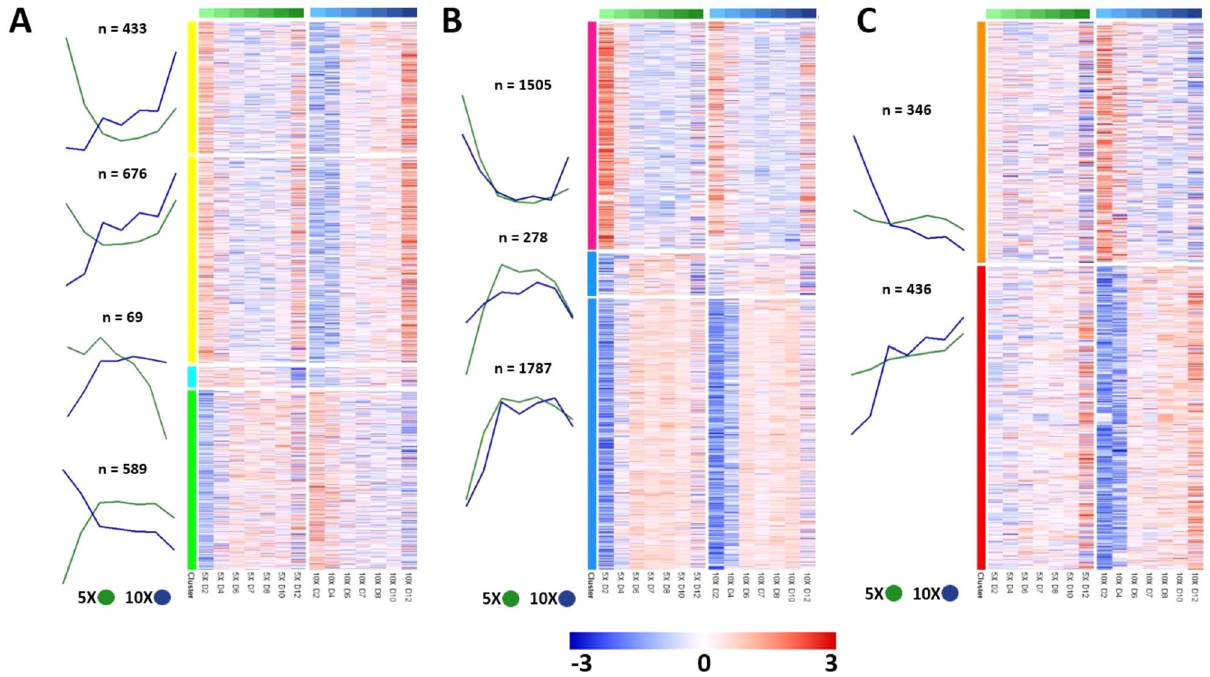
Figure 3. Somatic cells from follicles cultured in 5X versus 10X have distinct gene expression profiles in nine gene subsets. Mean expression plots with gene number and per-gene heatmaps for ( A ) gene subsets with different expression in 5X versus 10X, ( B ) gene subsets with similar expression in 5X versus 10X, and ( C ) gene subsets with more dynamic expression in 10X versus 5X. All plots were generated using pheatmap (version 1.0.12) 62 in R (version 3.6.9, https:// www.r- proje ct. org/) 55 in blue in Fig. 2B) mainly contains genes with delayed upregulation on Day 4 and a decline in regulation between Days 10 and 12. Genes of interest with high logFC in this cluster include Aurkb , Birc5 , and Mcm5 , which code for aurora kinase B, baculoviral inhibitor of apoptosis repeat-containing 5 (BIRC5), and the protein MCM5 respec- tively, all of which have known roles in the cell cycle and apoptosis, and Nlrp14 , coding for the protein NOD-like receptor family pyrin domain containing 4 (NLRP14), which has been studied in relation to primordial follicle survival and may have other roles in later stages of folliculogenesis 27,28 . All five top GO terms for this cluster were associated with cell cycle activity: “cell cycle” (GO:0007049, 267 genes), “cell cycle process” (GO:0022402, 217 genes), “mitotic cell cycle” (GO:0000278, 173 genes), “mitotic cell cycle process” (GO:1903047, 165 genes), and “nuclear division” (GO:0000280, 147 genes) (Supplemental Dataset S1). This period of upregulation from Days 4 to 10 reflects the proliferation of granulosa cells during follicular expansion, which ceases once the follicle has reached a terminal size (Fig. 2C). GOrilla analysis corroborated these findings, also reporting enrichment for terms related to DNA replication and the cell cycle (Supplemental Dataset S2). The fifth cluster (n = 1928 genes, labeled in orange), was comprised of genes with delayed activation, as they were upregulated starting on Day 6 (Fig. 2B). Genes of interest within this cluster included glycolysis-related genes like Aldoc (coding for aldolase C) and Pfkp (coding for phosphofructokinase), noteworthy because granulosa cells are known to have highly gly- colytic metabolic processes often regulated by oocyte-secreted factors 29 . The top GO terms for this cluster from LRPath were all related to metabolism: “steroid metabolic process” (GO:0008202, 54 genes), “lipid metabolic process” (GO:0006629, 146 genes), “small molecule metabolic process” (GO:0044281, 201 genes), “alcohol meta- bolic process” (GO:0006066, 50 genes), and “monocarboxylic acid metabolic process” (GO:0032787, 75 genes) (Fig. 2C) (Supplemental Dataset S1). The last cluster (n = 1378 genes, labeled in cyan in Fig. 2B) was comprised of genes with late activation in the final days of culture. Genes of interest in this cluster included Adm (coding for adrenomedullin) and Star (coding for steroidogenic acute regulatory protein), both of which drive steroi- dogenesis in the follicle, and Egln3 (coding for Egl-9 family hypoxia inducible factor 3) and Loxl2 (coding for lysyl oxidase like 2), which are both hypoxia-related 30,31 . Top GO terms from LRPath and GOrilla for this cluster included “positive regulation of gene expression” (GO:0010628, 86 genes) and “positive regulation of transcrip- tion, DNA-templated” (GO:0045893, 66 genes) (Fig. 2C) (Supplemental Dataset S1, Supplemental Dataset S2). Comparison between 5 and 10X transcriptome trajectories. While the results above focused on 5X-10X shared patterns, we also contrasted the 5X and 10X transcriptomes to identify genes and pathways with differing patterns of expression. The two datasets were filtered to select genes with dynamic temporal expression and high cohesion across the time series (Methods), thus eliminating genes with stochastic “spikes” in expres- sion. The resulting set of 6,119 genes were clustered into nine subsets using a 3 × 3 self-organizing map 32 , then subjected to gene ontology analysis of each subset (Fig. 3). The gene subsets showed three general patterns of